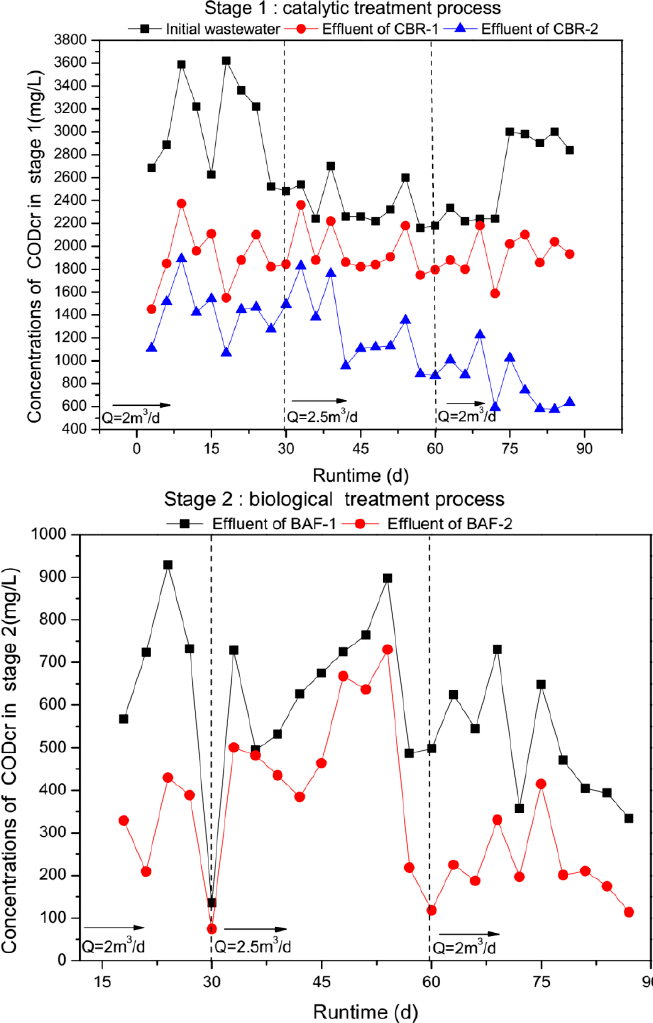
Figure 12. The concentration of CODcr in effluent in each stage. (stage 1: CBR-1 and CBR-2; stage 2: BAF-1 and BAF-2).